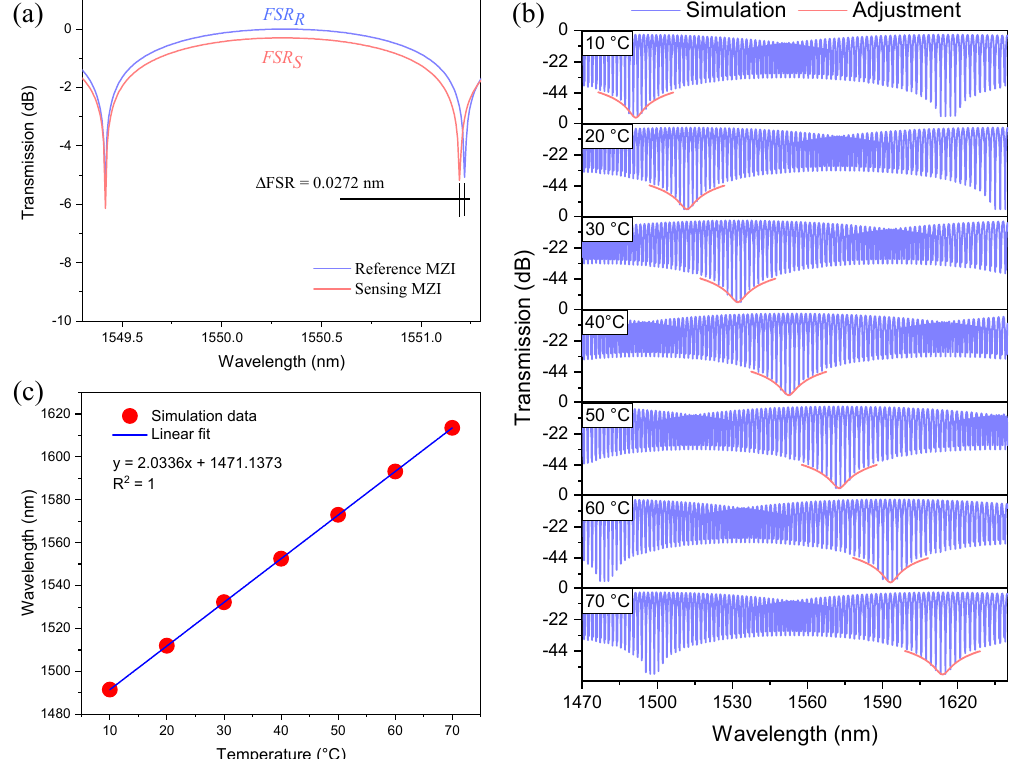
Figure 7. ( a ) Transmission spectra of the two MZIs with different lengths, ( b ) Transmission spectra of the two cascaded MZIs when the sensing MZI was at different temperatures, ( c ) Wavelength shift of the fitting enveloped dip as a function of temperature changes.